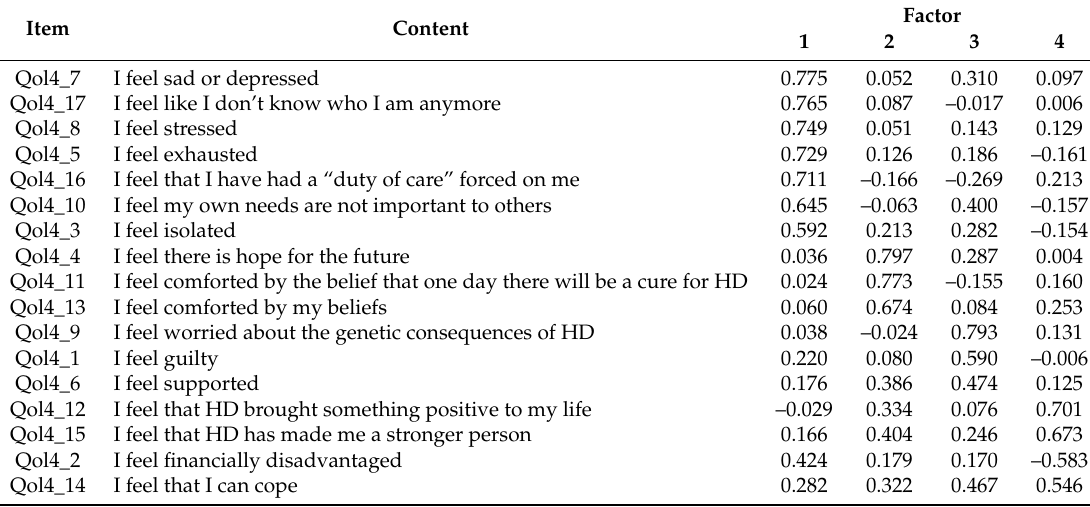
Table 4. Pattern Matrix of rotated factor loadings for section 4.